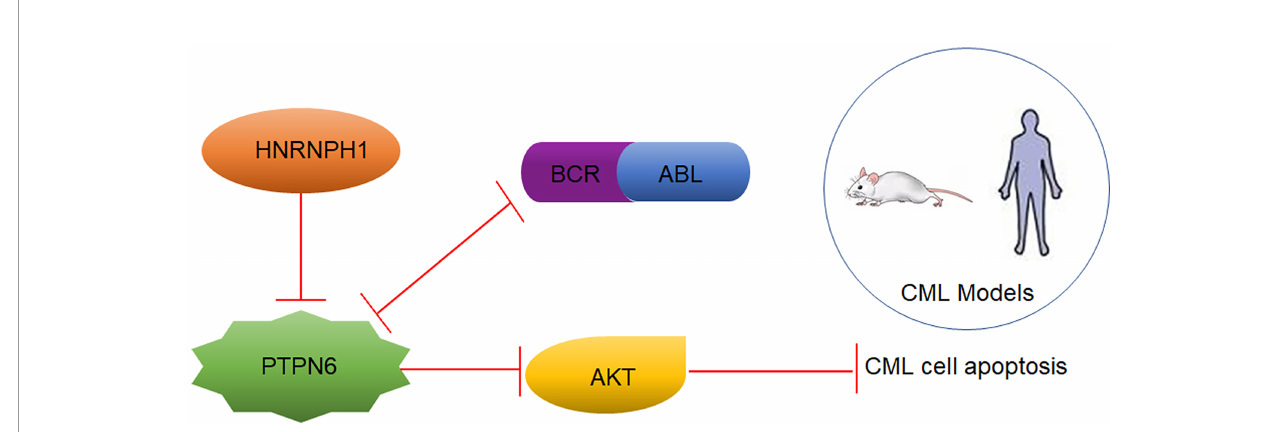
FIGURE 7 | A schematic model depicting the role of HNRNPH1 – PTPN6 – PI3K/AKT axis in